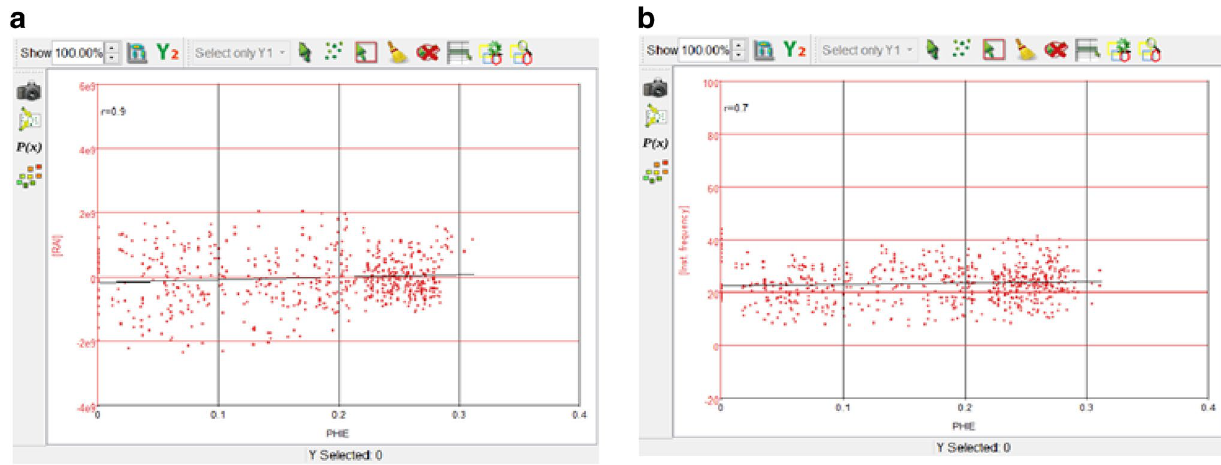
Fig. 9 a Cross plot of RAI vs Effective porosity. b Cross plot of instantaneous frequency vs Effective porosity